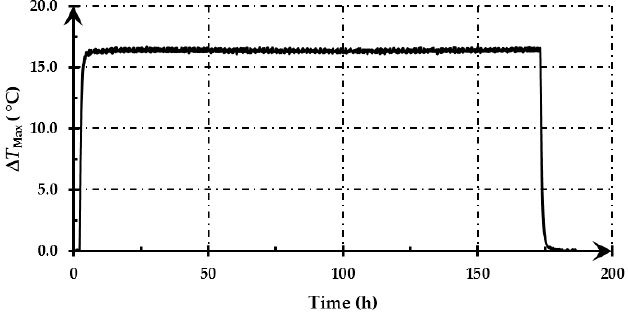
Figure 9. Chart of maximum temperature increments Δ T Max change during test U = 3.3 V, I = 2800 mA. Simultaneously taken measurements of the characteristic parameters (C) and ESR shown in Figure 10 displayed no changes (Figure 10 for ~450 cycles).